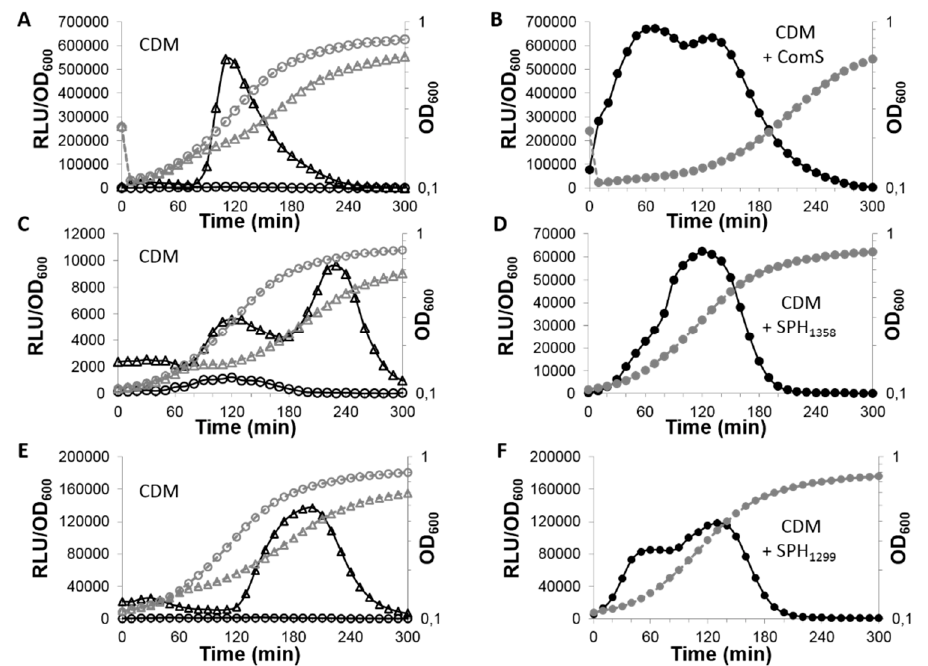
Figure 2. Growth and luciferase activity levels for strains that contained P comX - luxAB , P shp 1358 - luxAB , or P shp 1299 - luxAB fusions in a wild-type or a pptAB :: erm background and grown in CDM with or without a synthetic autoinducing peptide (AIP). The growth curves (OD 600 ) are presented in gray dotted lines, and the relative levels of luciferase activity (RLU / OD 600 ) in black solid lines. Results are shown for strains grown in CDM containing P comX - luxAB ( A ), P shp 1358 - luxAB ( C ), or P shp 1299 - luxAB ( E ) fusions with a wild-type background ( ∆ ) or pptAB :: erm background ( (cid:79) ) and for strains grown in CDM with the cognate AIP stated on the figure and containing P comX - luxAB ( B ), P shp 1358 - luxAB ( D ), or P shp 1299 - luxAB ( F ) fusions with a pptAB :: erm background ( • ). Data shown are representative of three independent experiments.